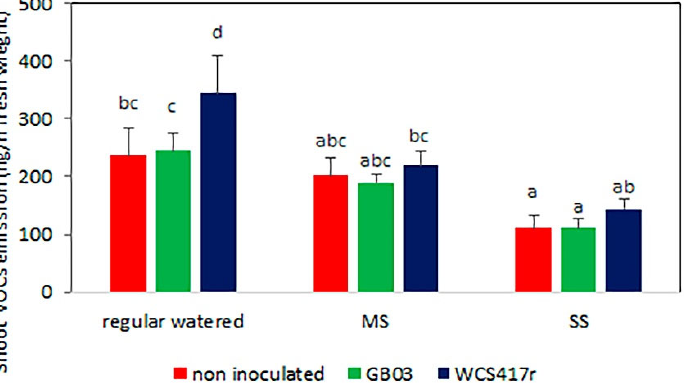
Figure 2. Variations in VOC emissions from peppermint plants subjected to moderate (MS) or severe drought stress (SS) and inoculated with different PGPR strains (mean ± SE). Different letters indicate significant differences between treatments based on Fisher’s LSD test (n = 15–20, p <0.05).